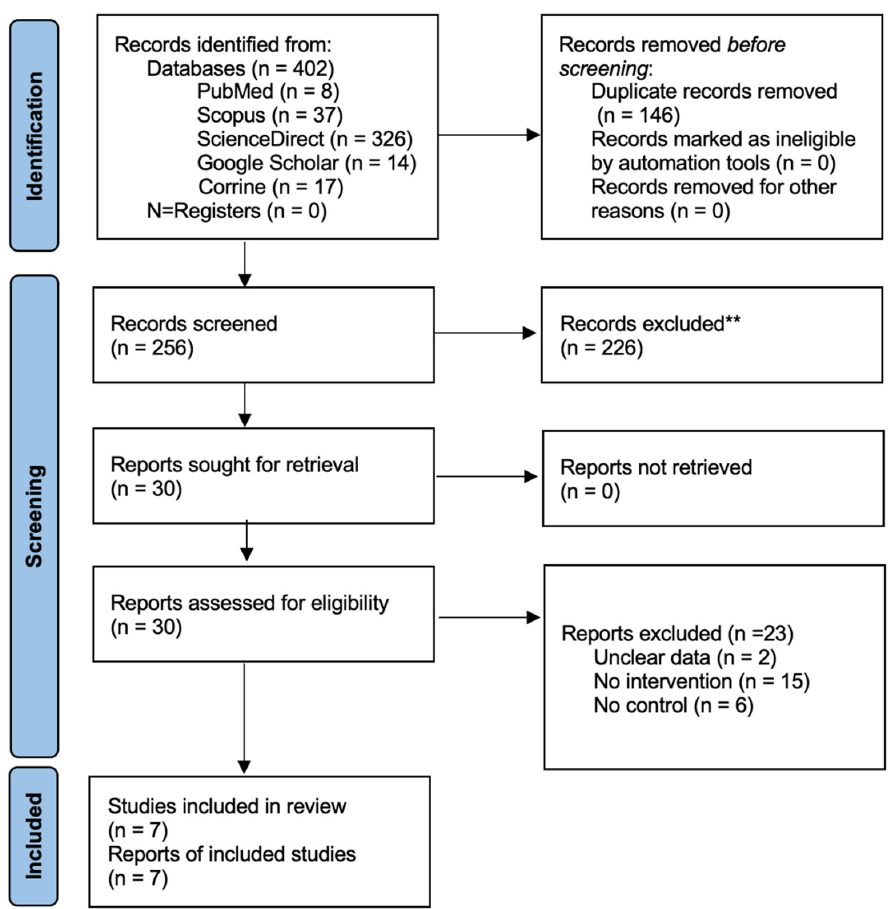
Figure 1. PRISMA flowchart for study selection.